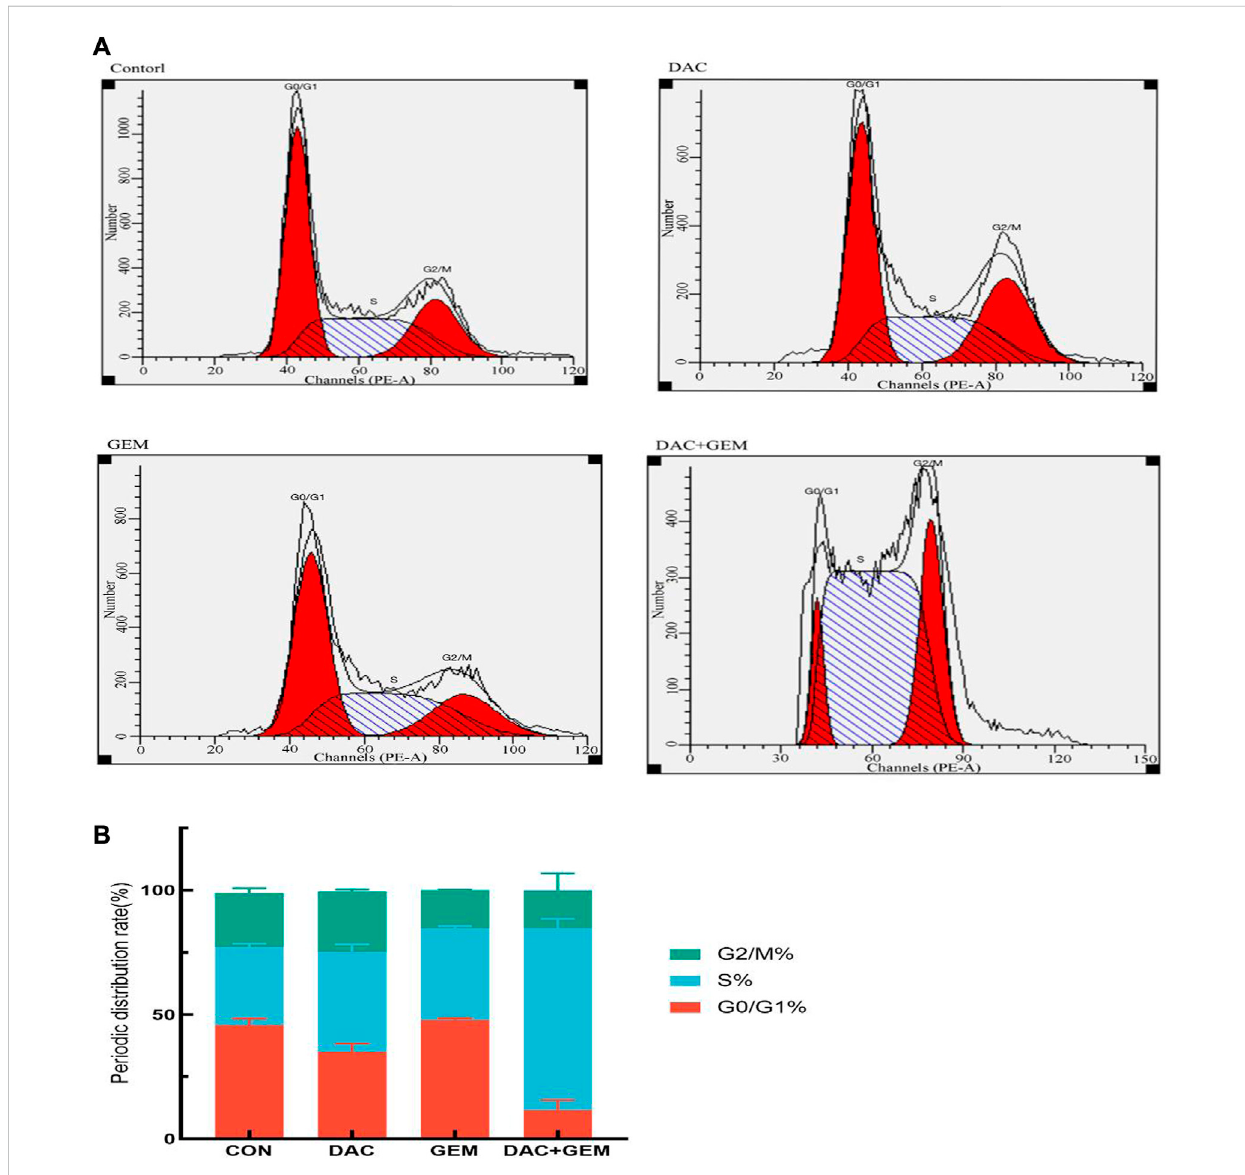
FIGURE 3 The cell cycle distribution of NK92MI cells after 48-h exposure to DAC and GEM. (A, B) The proportion of NK92MI cells in the S phase in the combination of DAC with 4.046 µM and GEM with 0.005 µM was signi fi cantly